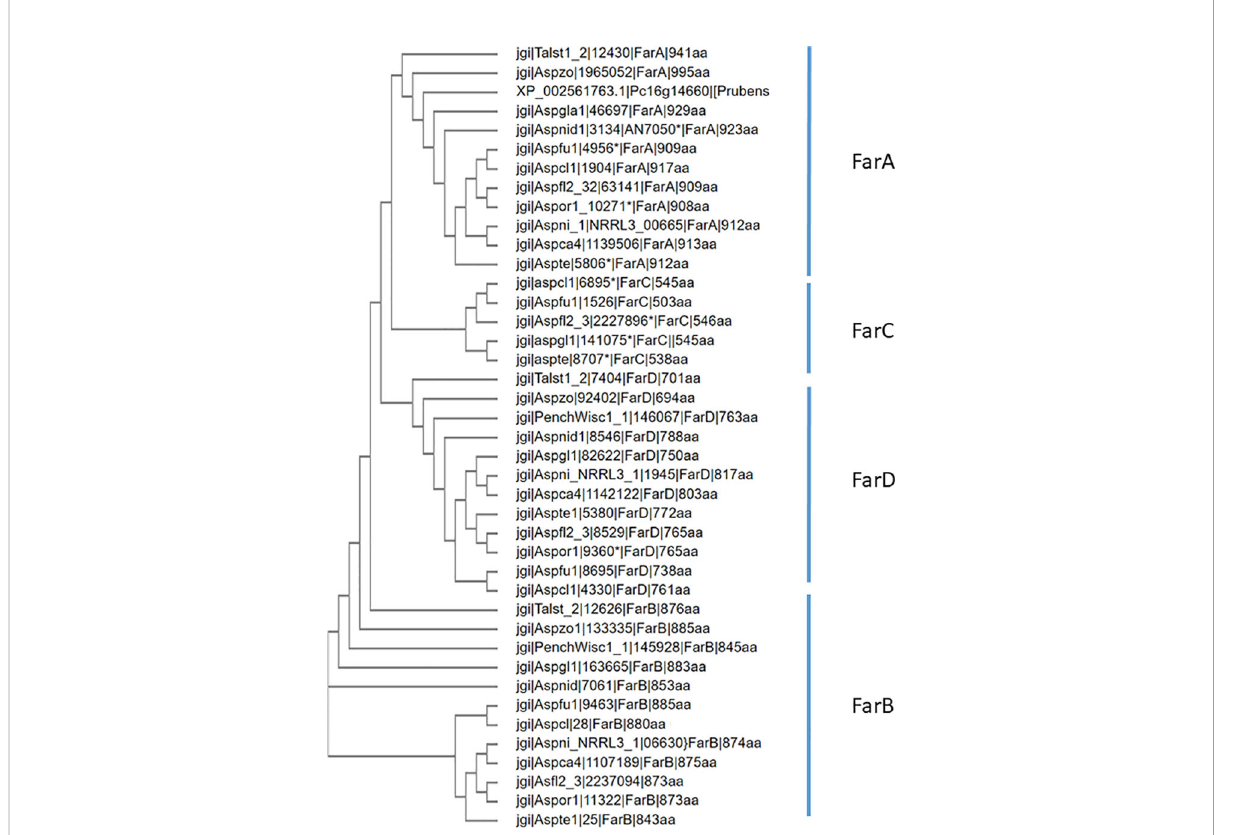
FIGURE 6 Phylogenetic analysis of Far transcription factors and Far-like transcription factor in the genomes of 12 representative Eurotiales fungal genomes. Using Far proteins from A. niger (FarA, FarB, FarD, NRRL3_11483 and NRRL3_07314 or A. fl avus (FarC) as queries, orthologous Far-like transcription factors were identi fi ed. Clustal omega was used to construct the phylogenetic